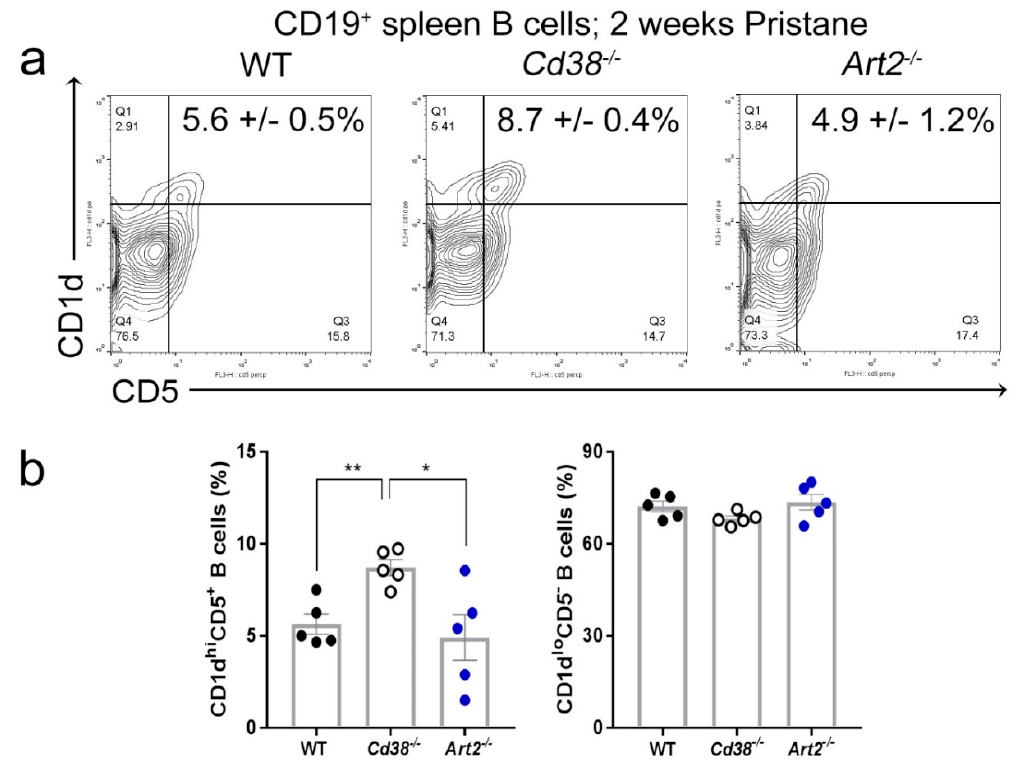
Figure 3. Increased frequency of CD1d hi CD5 + B cells in spleen from pristane-treated Cd38 − / − mice. ( a ) Spleen cells from 2-week pristane-treated mice were stained with anti-CD19-Allophycocyanin (APC), anti-CD38-Fluorescein isothiocyanate (FITC), anti-CD5-Peridinin-chlorophyll-protein complex (PerCP), and anti-CD1d-Phycoerythrin (PE) mAbs. Contour-plots of CD1d vs. CD5 of CD19 + -gated B cells of a representative experiment are shown. In quadrant Q2, the percentages ± SEM of CD1d hi CD5 + B cells are highlighted. ( b ) Bars represent mean ± SEM of frequencies of CD1d hi CD5 + B cells (left panel), and CD1d lo CD5 − B cells (right panel) in spleen of WT, Cd38 − / − , and Art2 − / − mice injected i.p. with pristane 2 weeks before. Each dot represents the value from 1 distinct mouse ( n = 5 mice per group). * p = 0.0203; ** p = 0.0022. Unpaired t -test. The results are representative of at least two independent experiments.